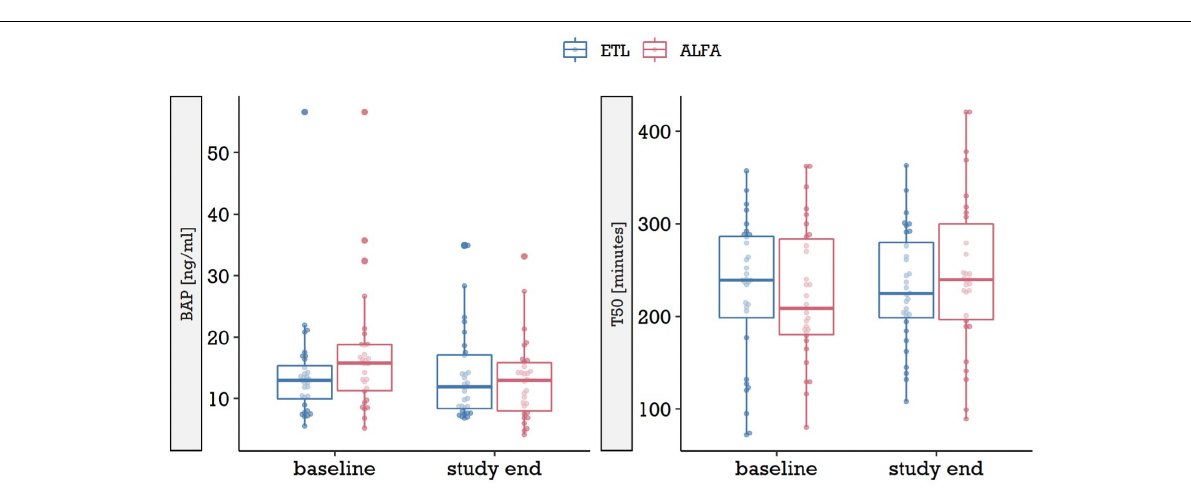
FIGURE 2 | BAP and serum calcification propensity score test (T50) at baseline and study end in the two treatment arms, ETL and ALFA. Due to outliers with very high levels, for each marker and point in time the data was clipped at the respective 97.5% quantile, i.e., levels above it were set to the 97.5% quantile